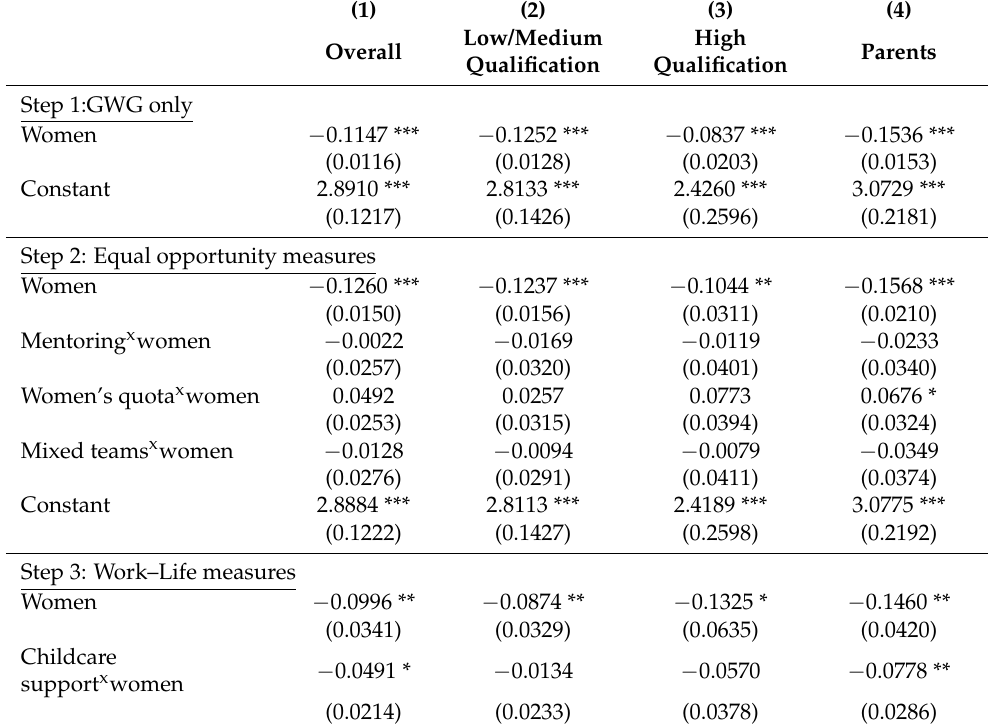
Table 3. The association of equal opportunity/work–life measures and log hourly wages (multi-level linear regression models with organizational fixed